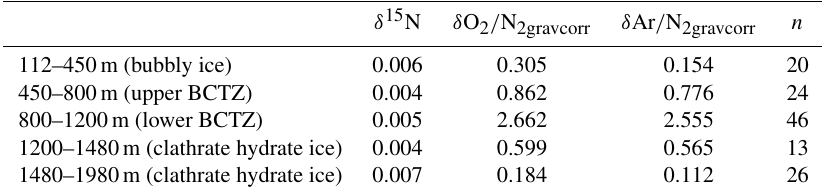
Table C1. Pooled standard deviations for δ 15 N, δ O 2 / N 2gravcorr , and δ Ar / N 2gravcorr (‰).